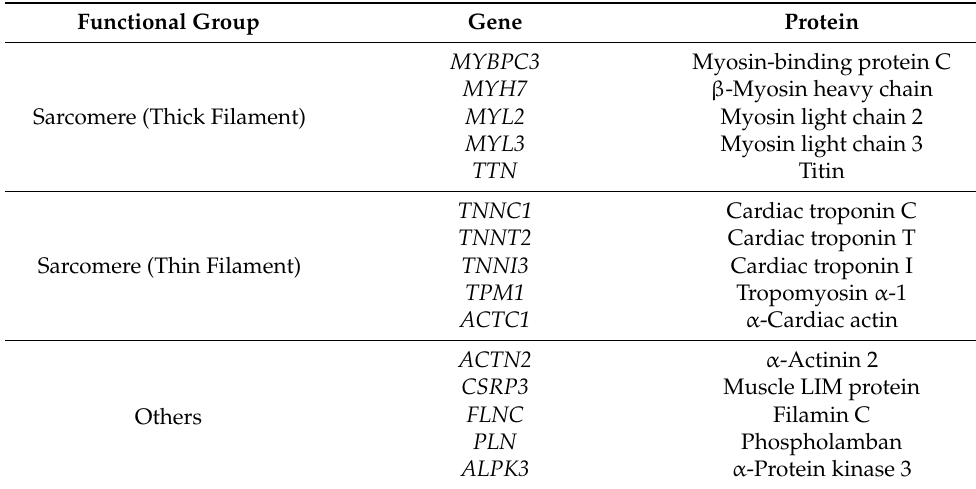
Table 2. Representative causative genes of hypertrophic